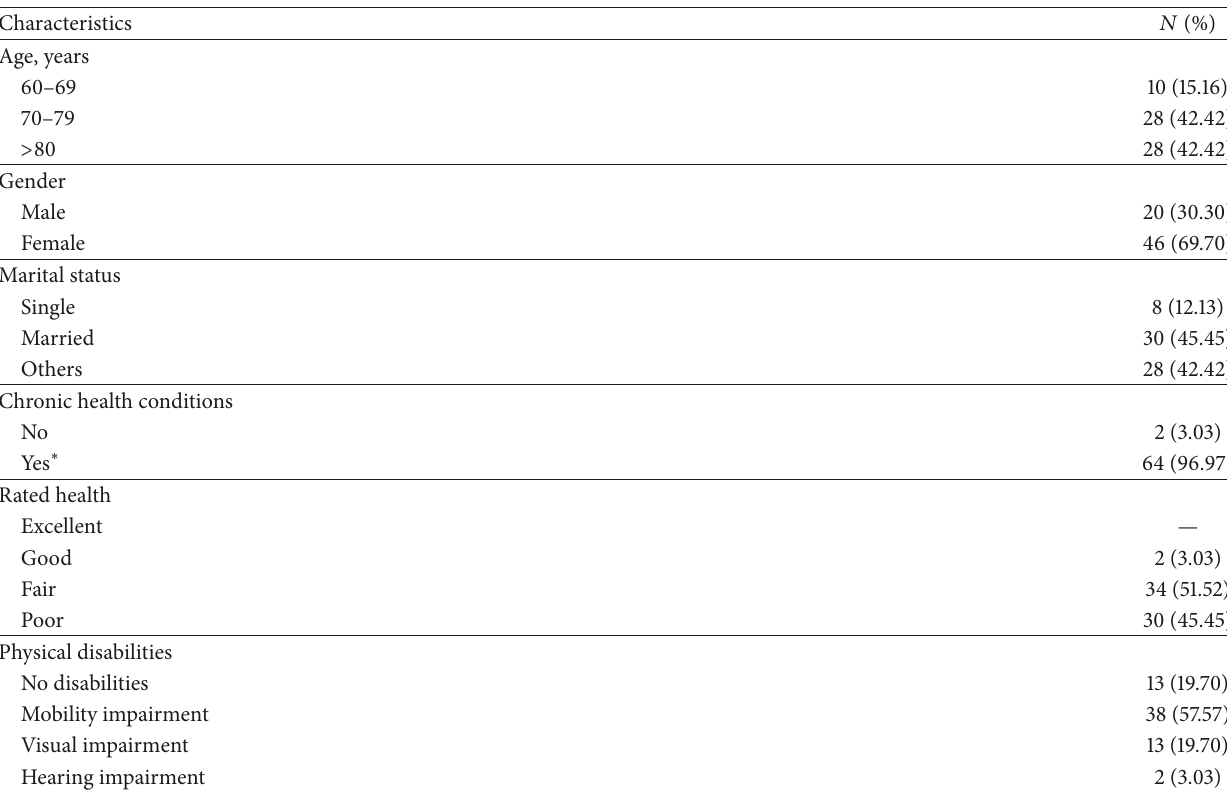
Table 3: Characteristics of the home-bound elderly ( 𝑁 = 66 ).